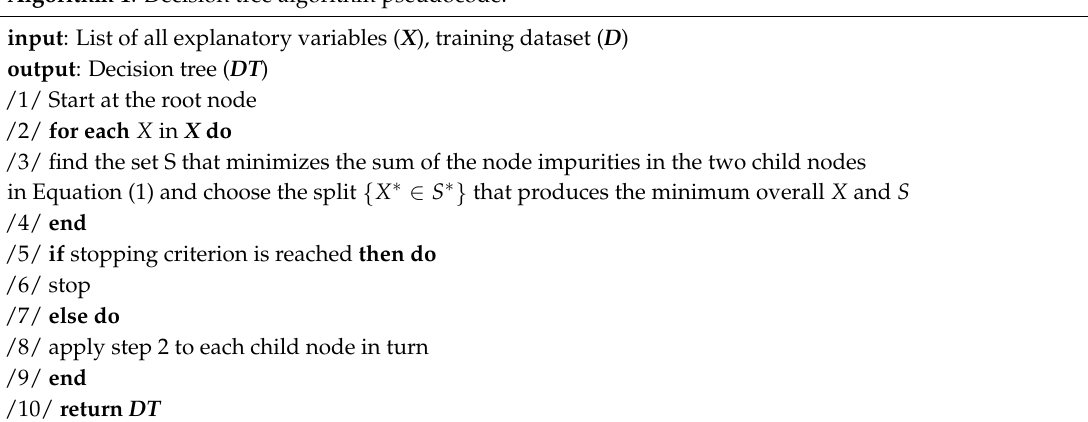
Algorithm 1 : Decision tree algorithm